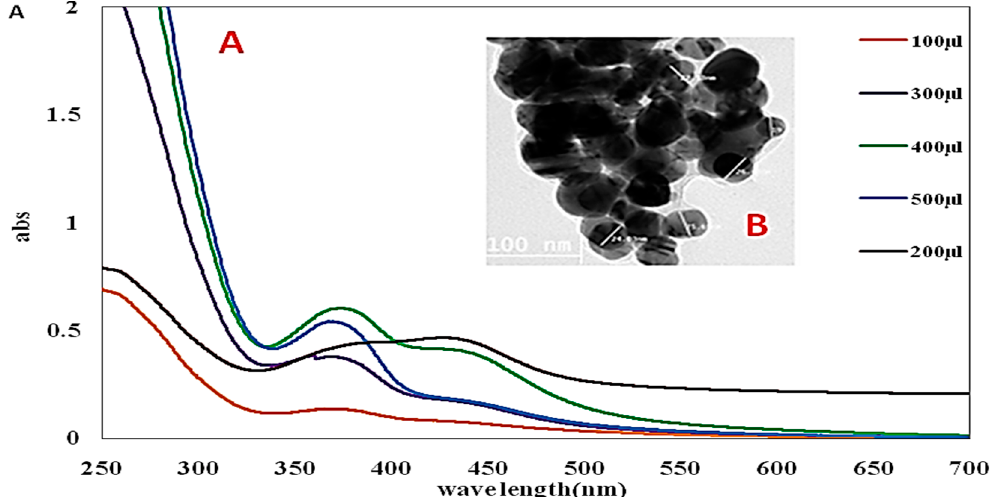
Figure 1. ( A ) The SPR band of Ag-NPs recorded by UV–vis spectra as a function of varying concentrations (100, 200, 300, 400, and 500 µL). ( B ) TEM image of A ASBE-Ag-NPs.